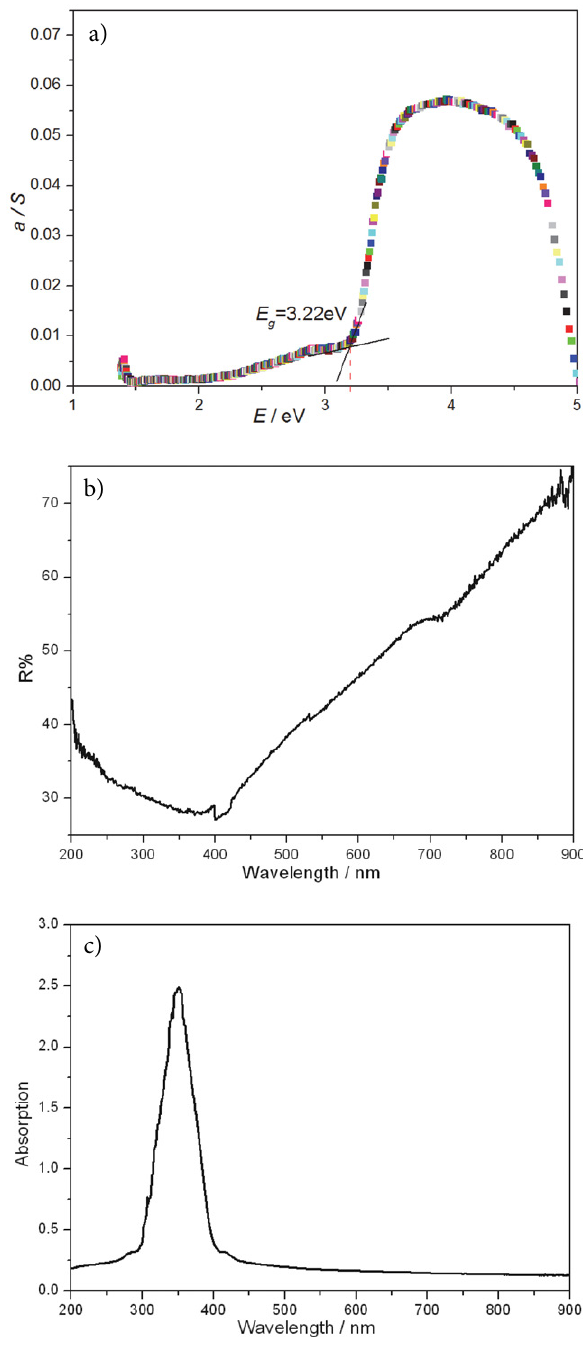
Fig. 8. (a) the solid–state UV-Vis diffuse reflectance spectrum of the title complex; (b) normal UV-vis diffuse reflectance spectra; (c) normal UV-vis absorption spectra measured in DMF